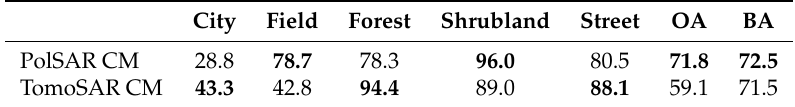
indicated in bold font.